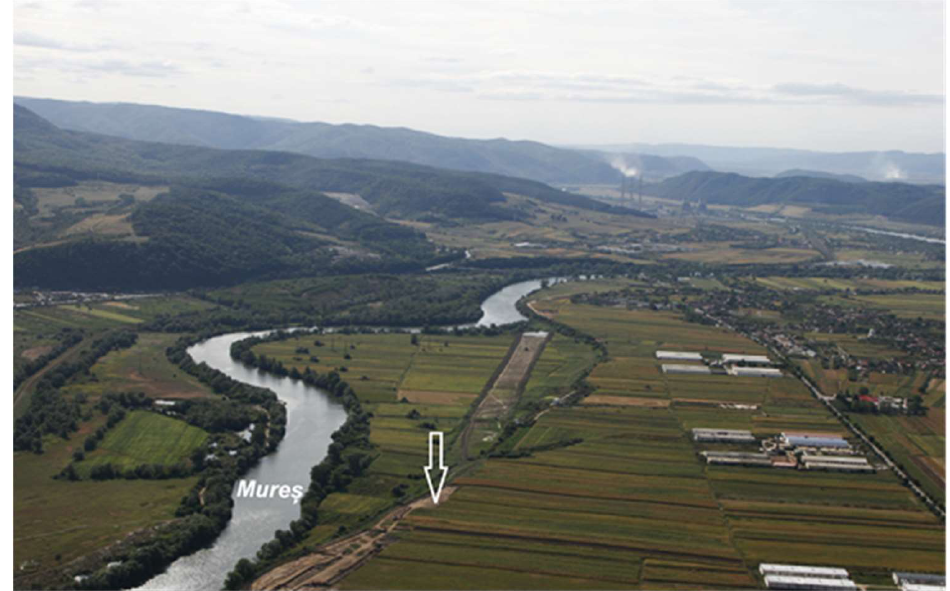
Figure 2. Aerial view of the archaeological excavations at Teleghi, nearby Șoimuș (photo: C. Bem). The white arrow marks the location of the Teleghi site and the area of the Early Neolithic feature C.18.